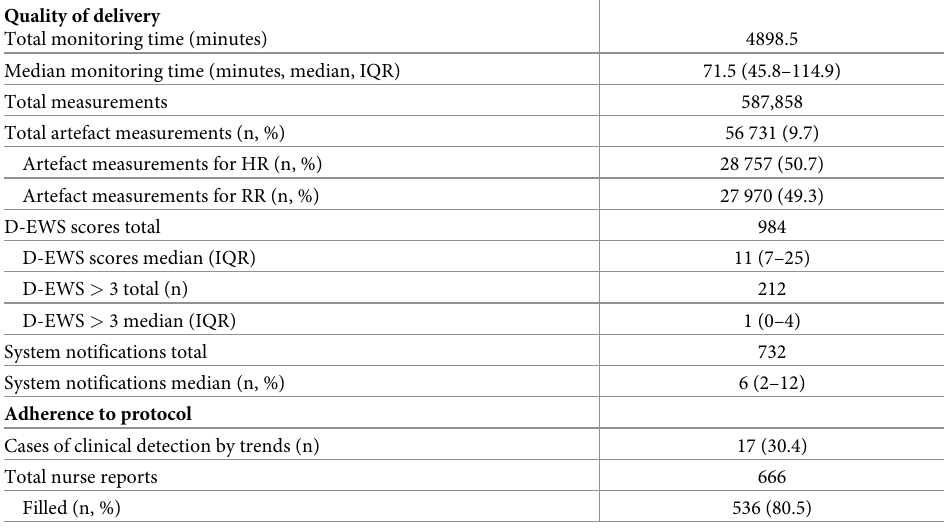
Table 4. Fidelity of the monitoring